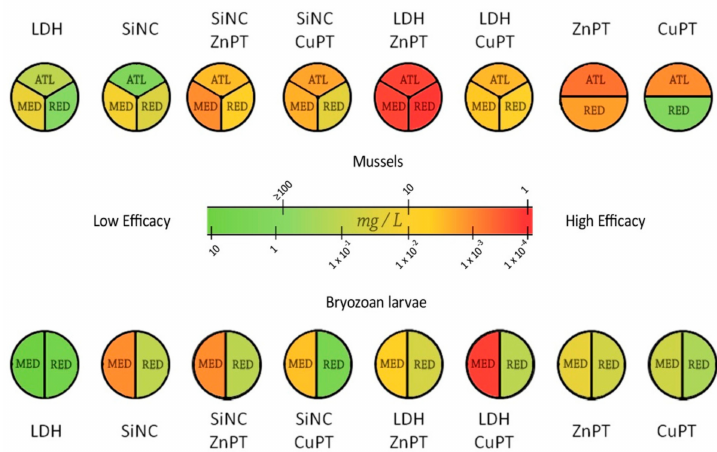
Figure 5. Compilation of antimacrofouling efficacy of ENMs: score based on tested mussels and bryozoan larvae under different concentrations in relation to